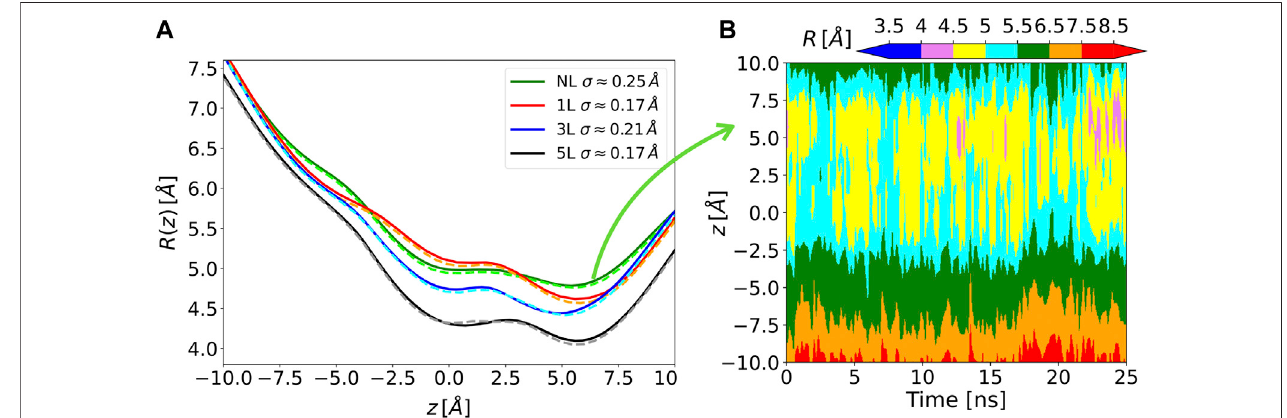
FIGURE 3 | (A) Solid lines, time-averaged channel radius along with the axial z position for each of the considered systems as obtained by Chanalyzer with associated SD (in the legend). Dashed lines, the same radius derived via the HOLE software. (B) Example of the dynamical behavior for the no-ligand system. The colormap is associated with the instantaneous value of the radius, as returned by Chanalyzer.